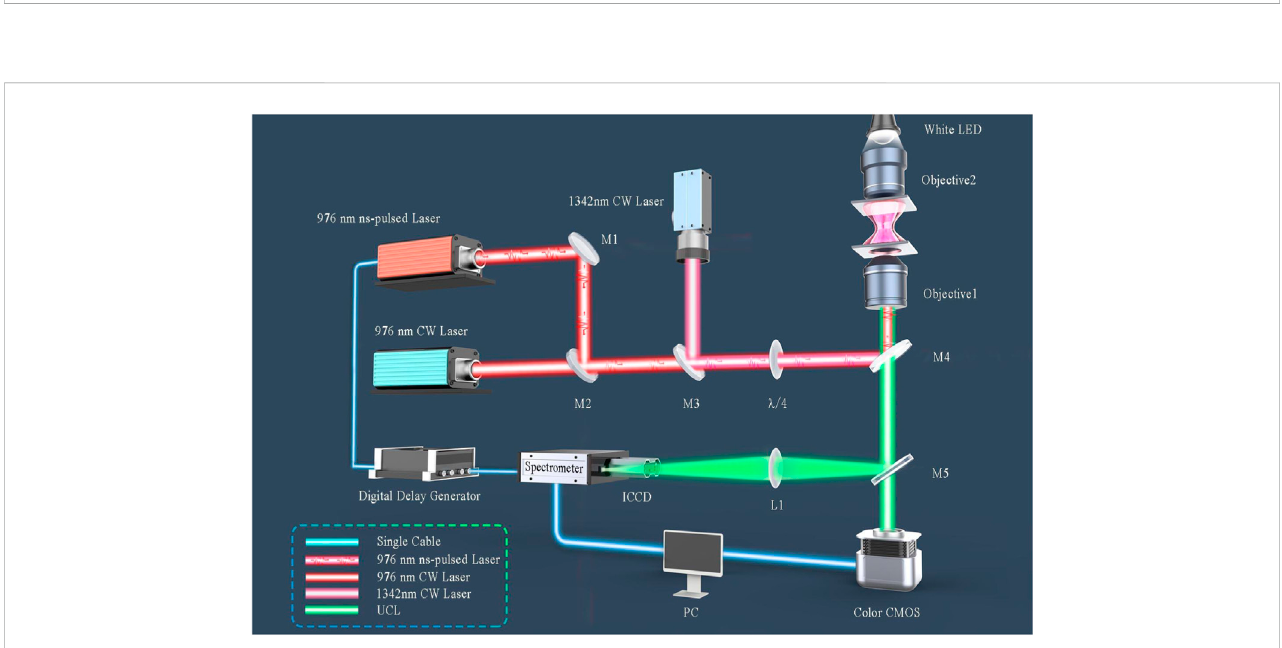
FIGURE 2 Setups for UCL detection with the self-built OT-TRPLS device. M1, planar re fl ective silver mirror; M2, polarization beam-combining mirror (for a 976 nm laser); M3,beam-combining mirror (fora976 nmlaser and1342 nm laser); M4, dichroic mirror for short-wave passand thecutoffwavelength is900 nm; M5, 50:50 beam-splitter. Objective 1 is an oil lens (1.3 NA, 100x). Objective 2 has 10 × magni fi cation with .25 NA for lighting focusing. All lasers were